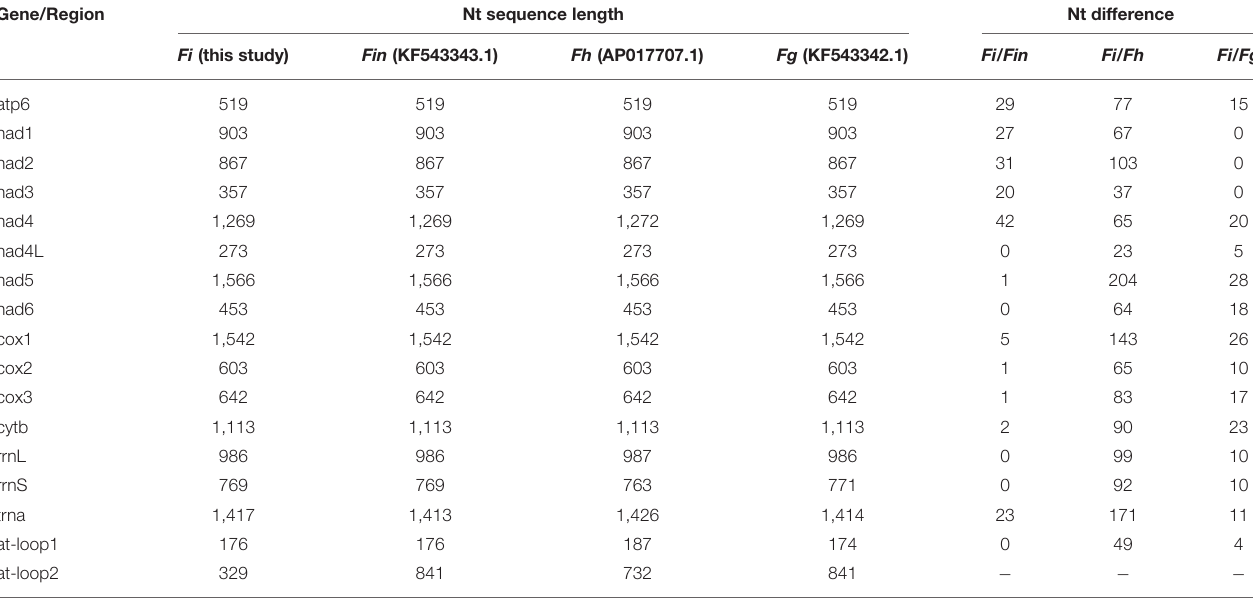
TABLE 5 | The sequence differences of nucleotide (nt) in each mt gene among F. intermediate , F. gigantica and F. hepatica . Gene/Region Nt sequence length